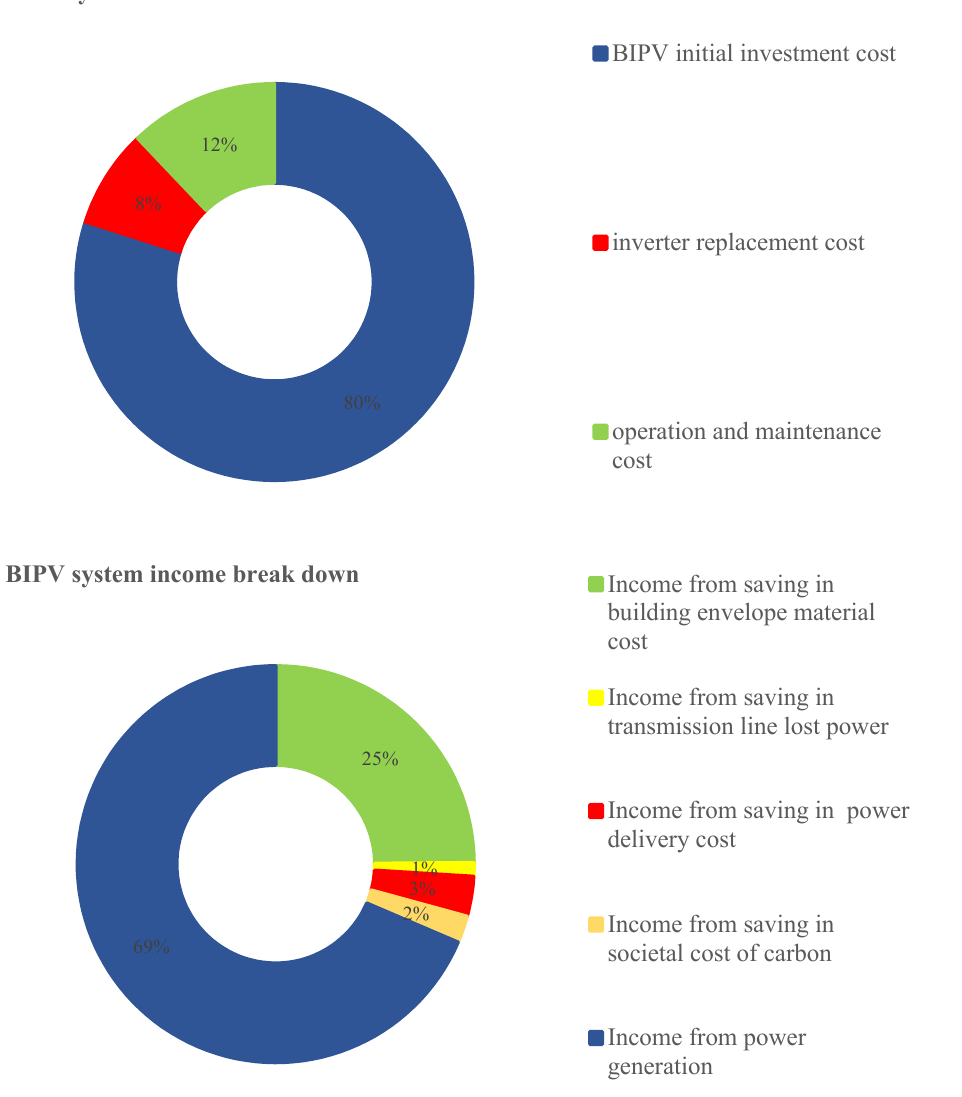
Figure 3. BIPV system cost and income break down in Europe.